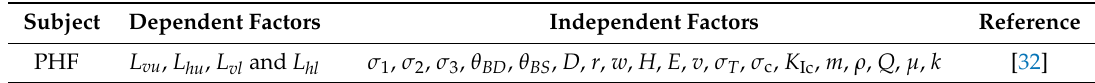
Table 4. Important factors governing prescribed hydraulic fractures.